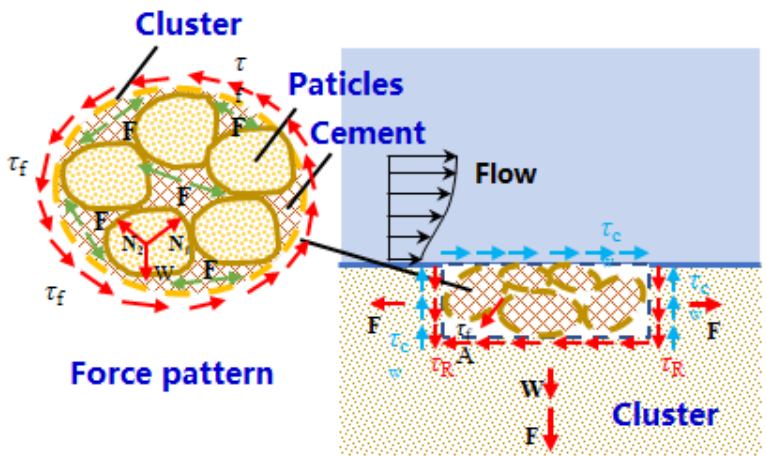
Figure 16. Schematic diagram of the water flow and the scour resistance of solidified soil during erosion.